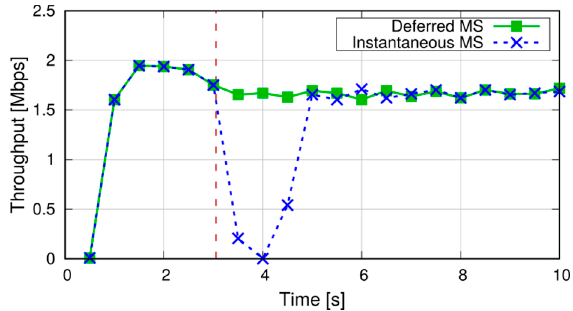
Figure 24. Application-level throughput of the TCP connection at a MS.